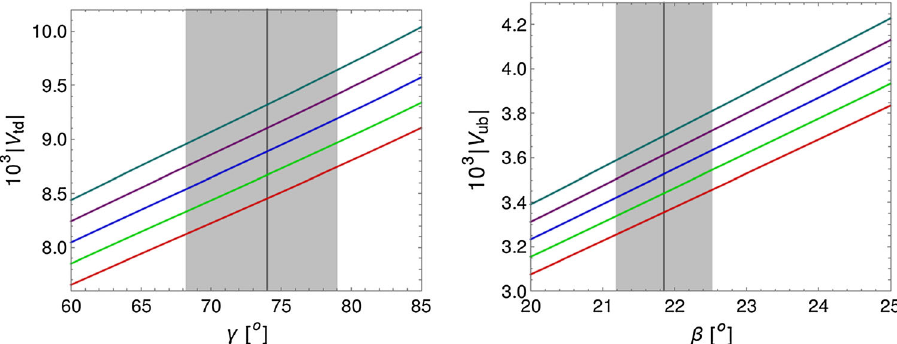
Table 1 Values of the experimental and theoretical quantities used as input parameters. For future updates see PDG [22] and HFLAV [6] = 5366 . 8 ( 2 ) MeV [22] m m B s